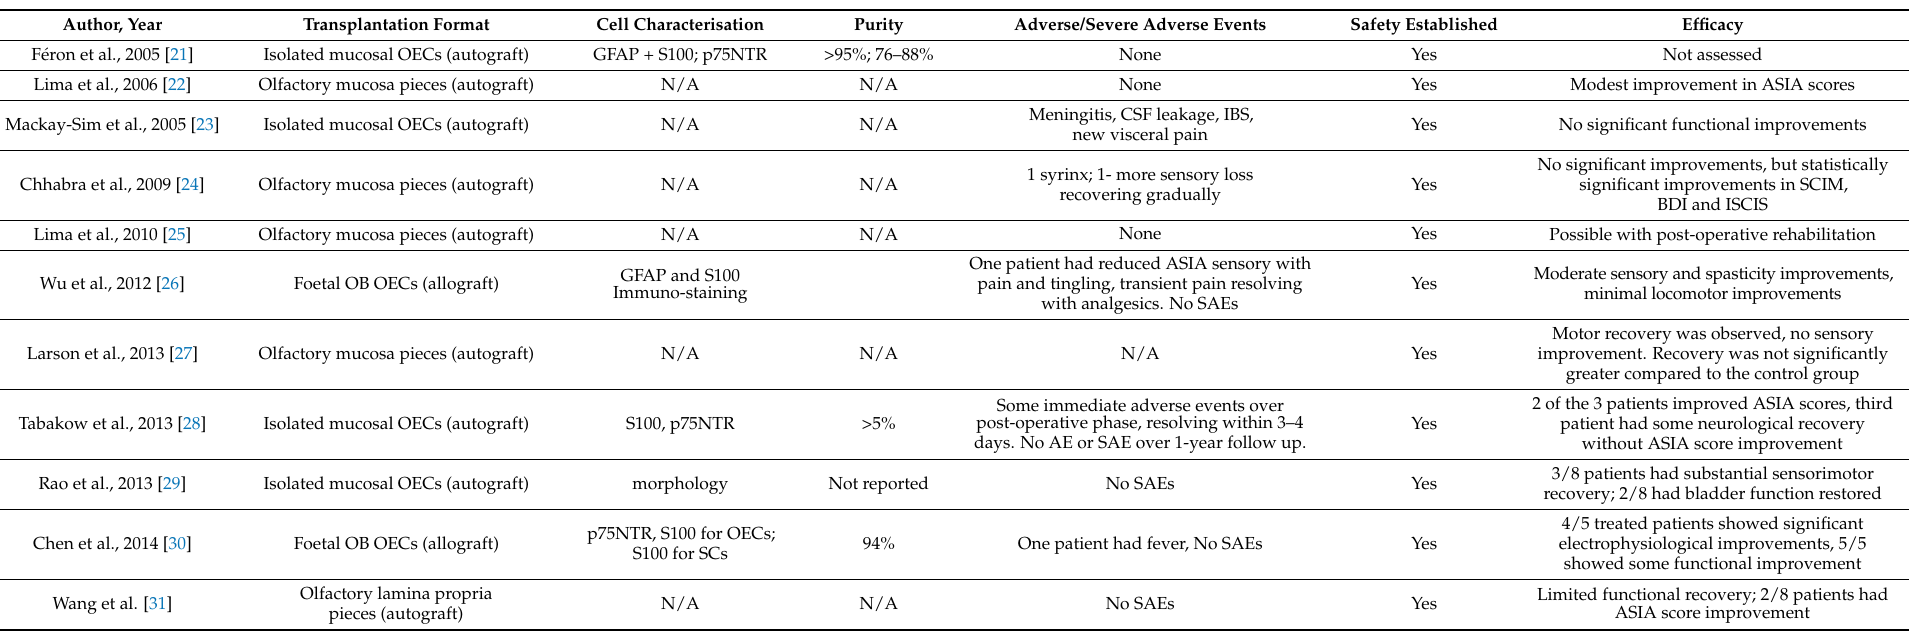
Table 1. A summary of details of interest regarding clinical trials design and